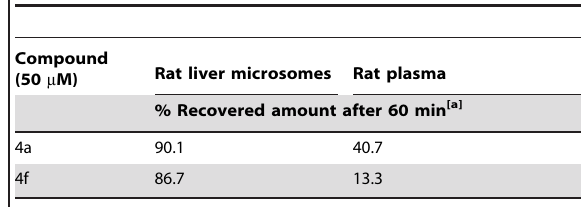
Table 3. In vitro stability of compounds 4a and 4f in rat liver microsome and rat